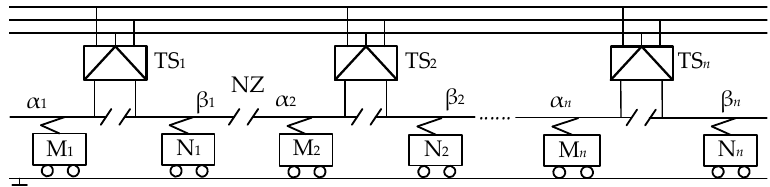
Figure 2. Sectional powered railway traction system.